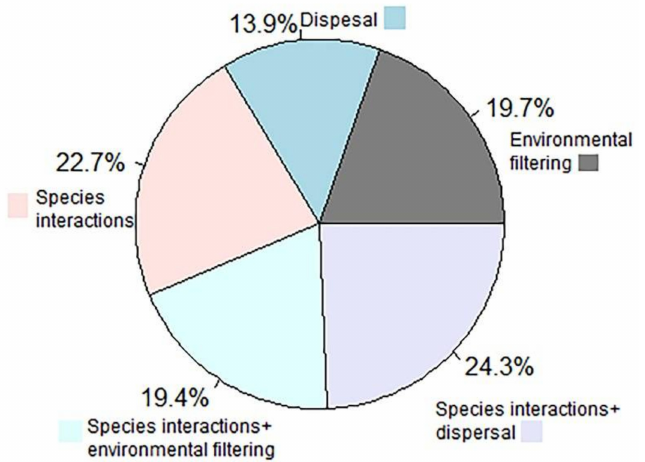
Figure 6. A pie chart showing the relative frequency of drivers behind changes in the spatial patterns of